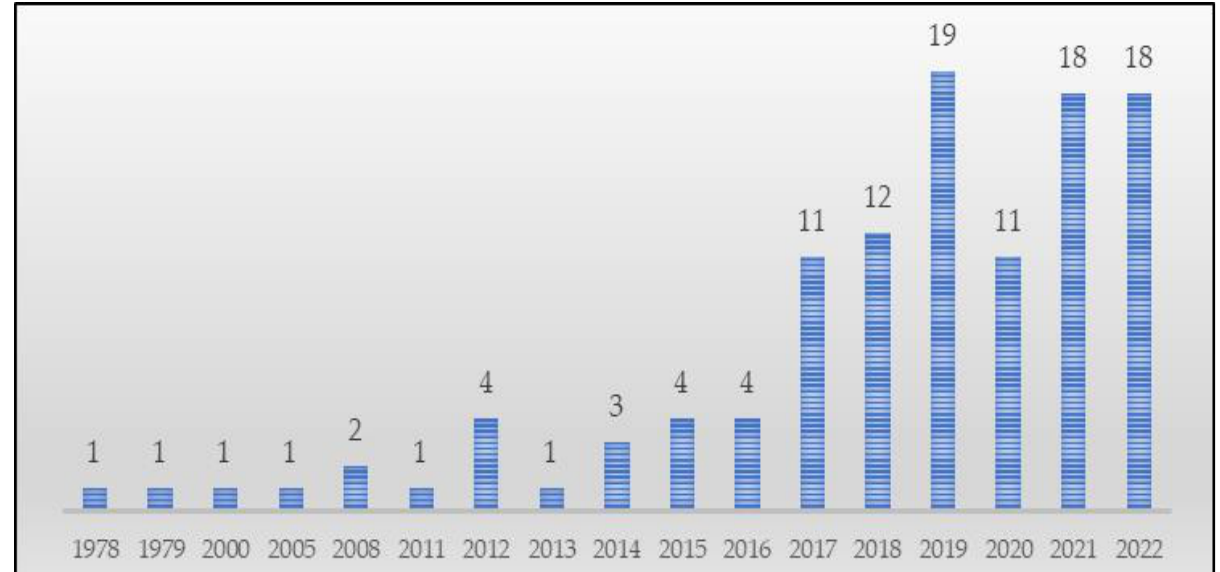
Figure 2. Record count of annual publication rate.